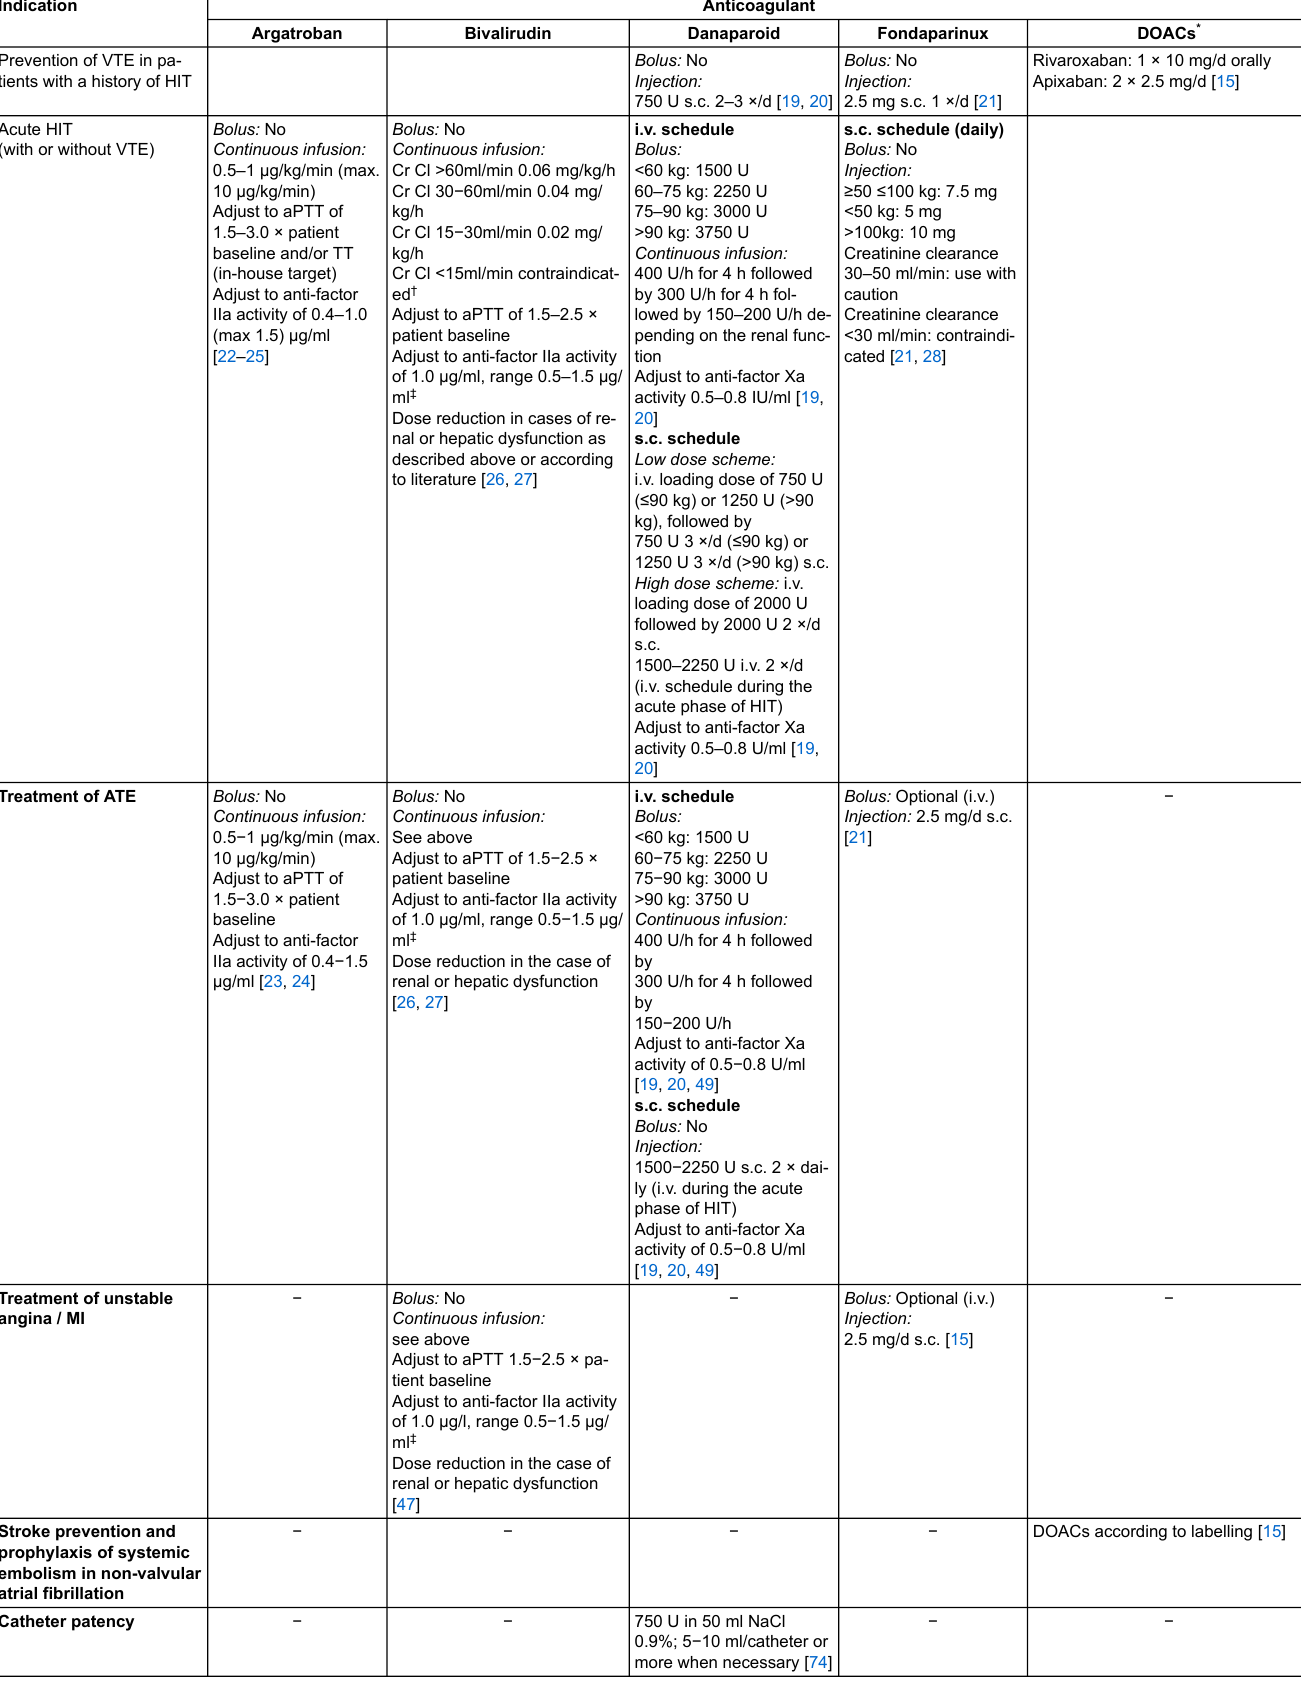
Table 3: Dosing schedules of anticoagulants in patients with heparin-induced thrombocytopenia. Indication Prevention of VTE in pa- tients with a history of